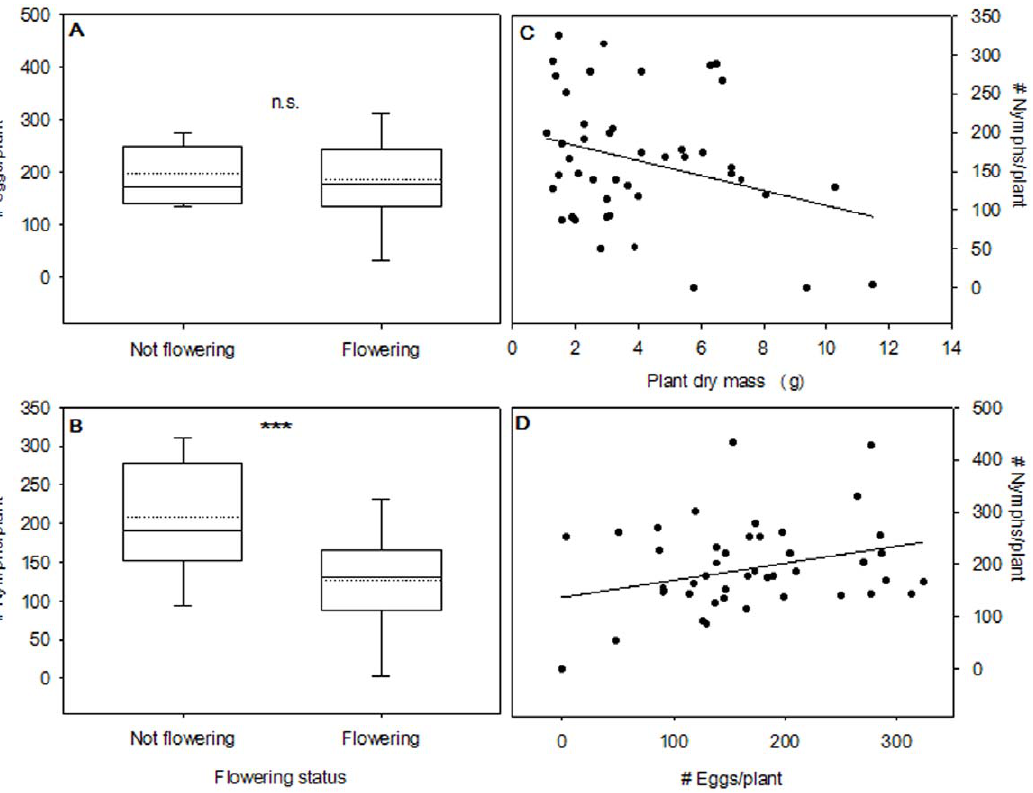
Figure 3. Psyllid rearing experiment. (A) Box-and-whiskers plot denoting the distribution of psyllid eggs/plant by flowering status; (B) Box-and- whiskers plot representing the distribution of psyllid nymphs/plant by flowering status (*** P , 0.001); (C) the correlation between plant size and psyllid nymphs/plant ( N =45, regression equation: [nymphs/plant]=202.304 2 9.625 [Plant dry mass (g) ]); and (D) the correlation between psyllid oviposition ( # eggs/plant) and nymph production ( # nymphs/plant; N =45, regression equation: [nymphs/plant]=107.677 + 0.292 [eggs/plant]). The dotted lines in (A) and (B) show the mean of each distribution.